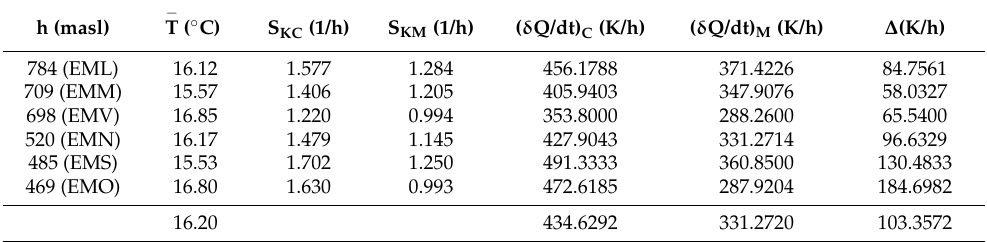
Table 7. Contains the average temperature for the measurement period 2017–2020 and the dif- ference between temporary heat variation between pollutants and meteorological variables using Equation (30). The last row are average